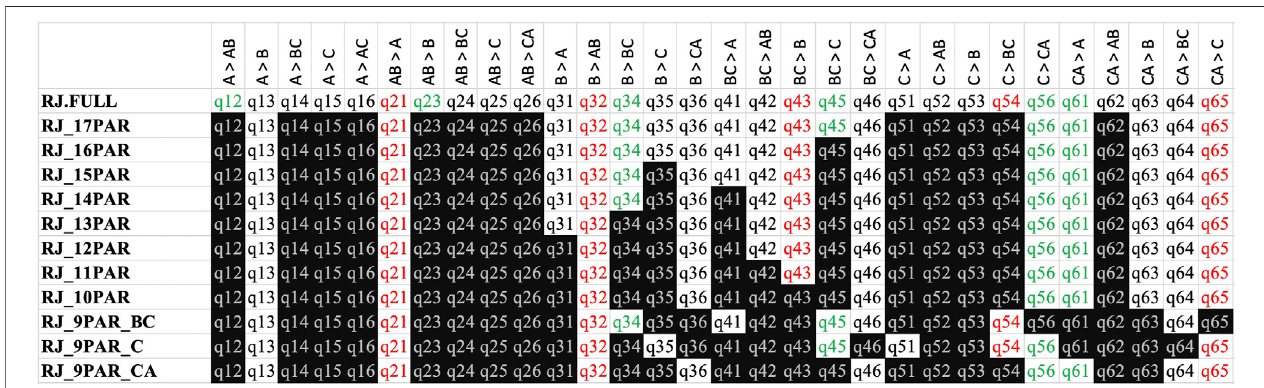
FIGURE7| OverviewofRJmodels.Shadedtransitionrateparametersareexcluded;nonshadedtransitionrateparametersareincluded(butnotnecessarilyturned on in the posterior models). Green indicates the six transition rate parameters that model the NEC; red indicates the transition rate parameters that revert the